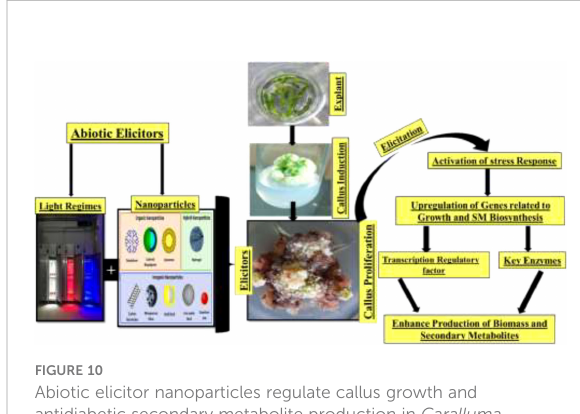
FIGURE 10 Abiotic elicitor nanoparticles regulate callus growth and antidiabetic secondary metabolite production in Caralluma uberculate callus.